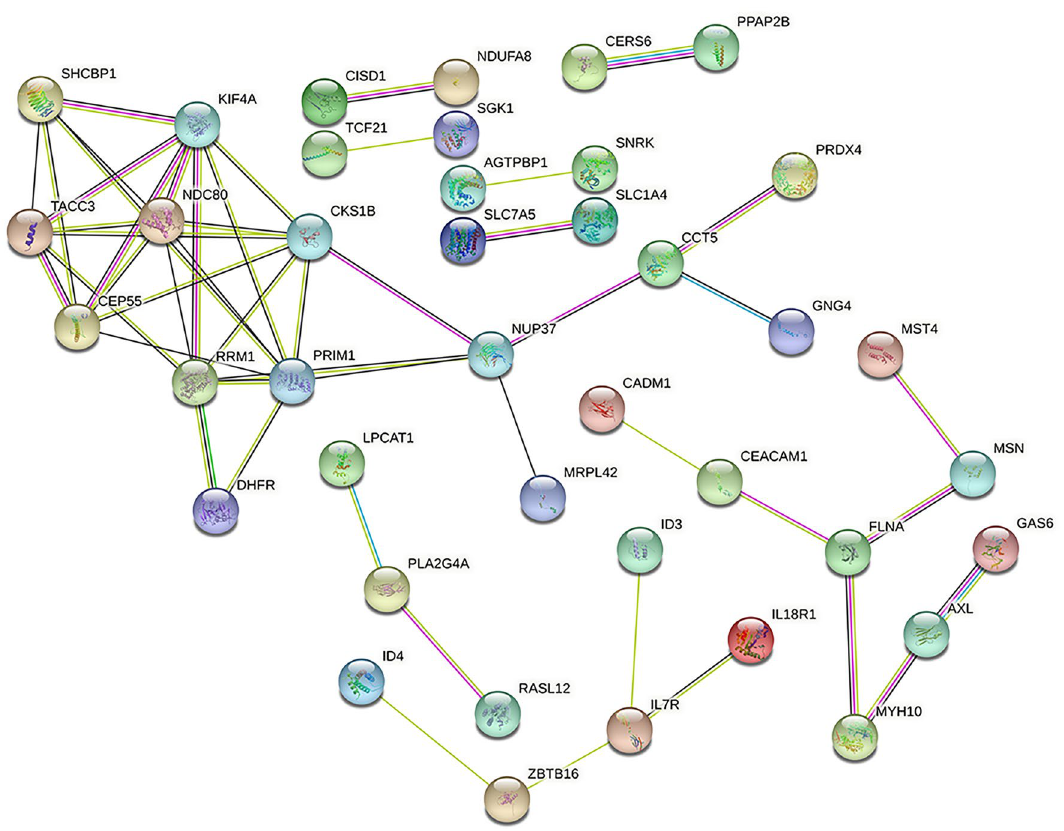
Figure 4. PPI network of common DEGs among IPF, COVID-19, SCLC, NSCLC, and CRC lung metastases.